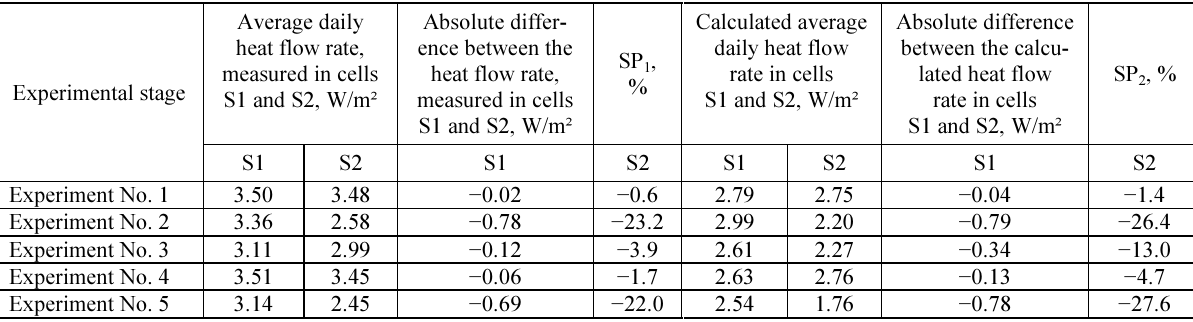
Average daily Absolute differ- Calculated average Absolute difference heat flow rate, ence between the daily heat flow between the calcu- SP 1 , SP 2 , % measured in cells heat flow rate, rate in cells lated heat flow % S1 and S2, W/m² S1 and S2, W/m² measured in cells rate in cells S1 and S2, W/m² S1 and S2, W/m² S1 S2 S1 S2 S2